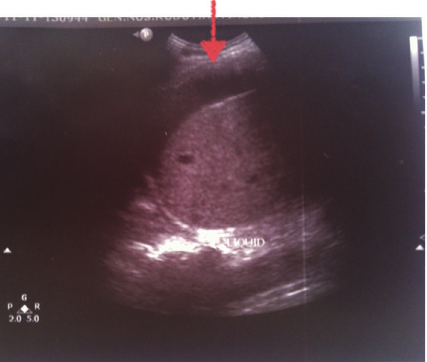
Figure 2: CT of the abdomen showing the subcapsular collection (arrow).